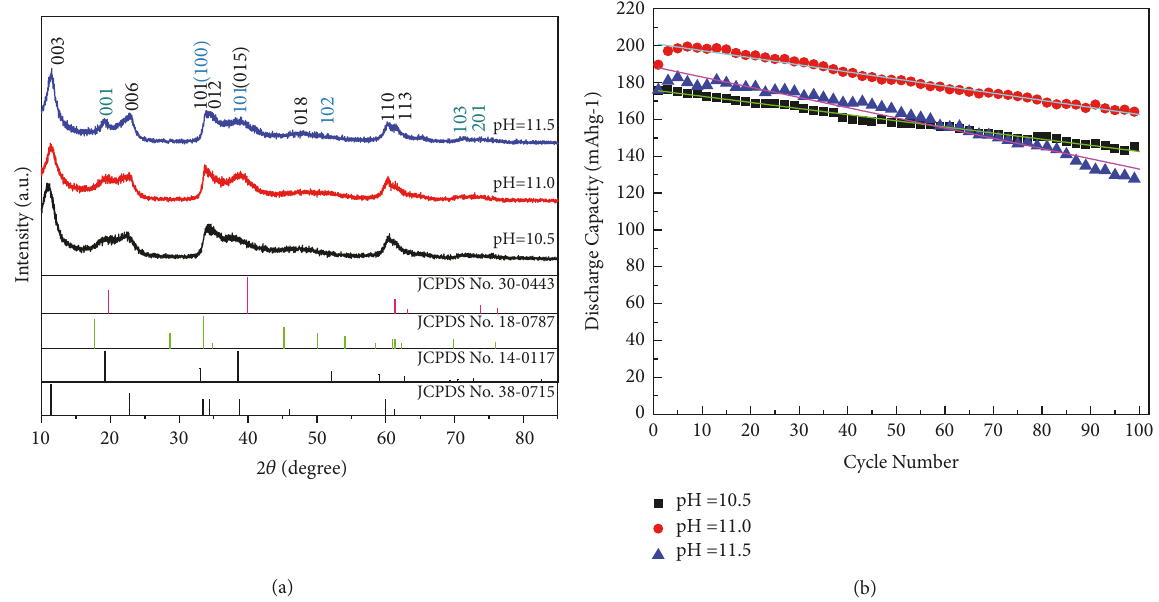
Figure 3: (a) XRD diffraction patterns of (Ni 0.6 Co 0.2 Mn 0.2 )OH 2 and (b) cyclic performance curve of NCM622 with different pH values